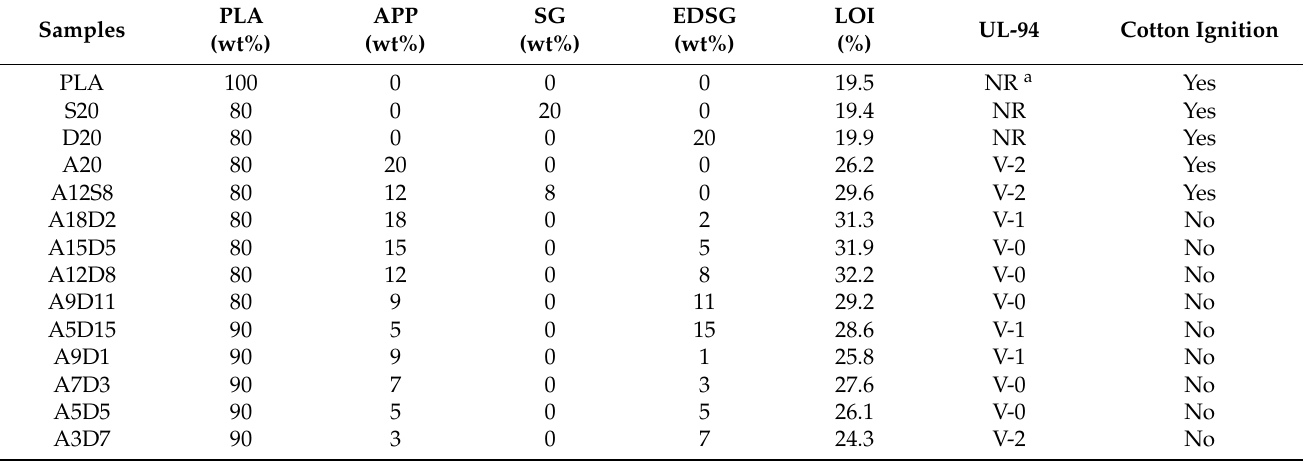
Table 1. Formulations and flammability of PLA and flame-retardant PLA